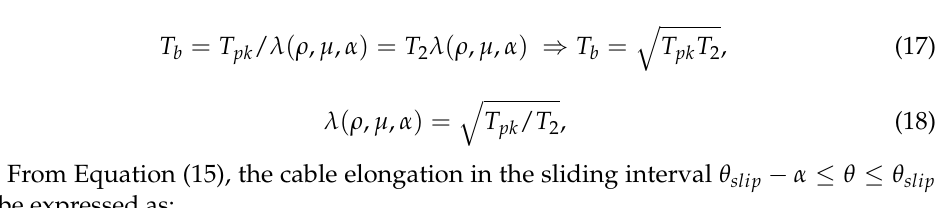
( b ) Tension distribution of the cable under unloading.